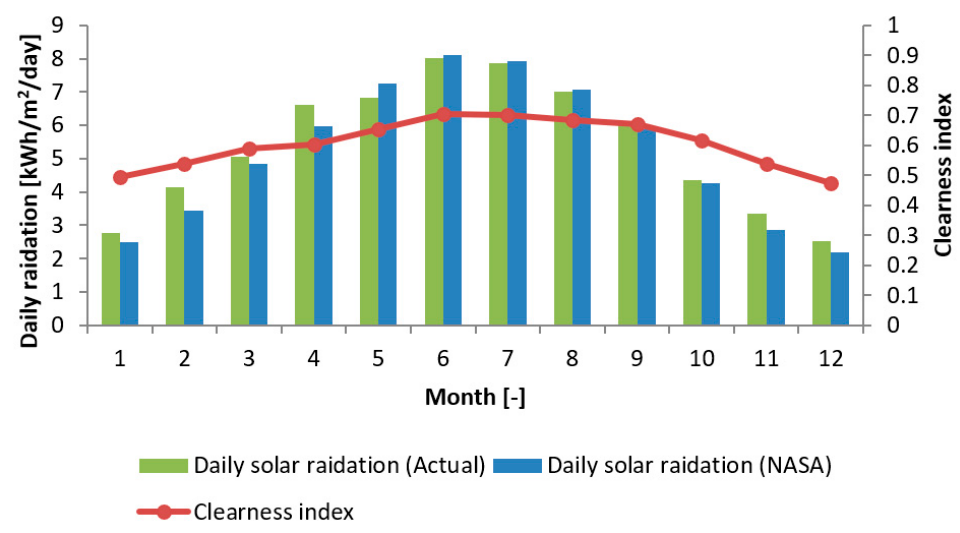
Figure 7. Monthly variation of the daily solar radiation and clearness index for the selected location. Table 5. Daily solar radiation titled, annual solar radiation-tilted and the annual energy exported and the capacity factor for various tilt angle and azimuth angle = 0 ◦ . Solar Panel used in the